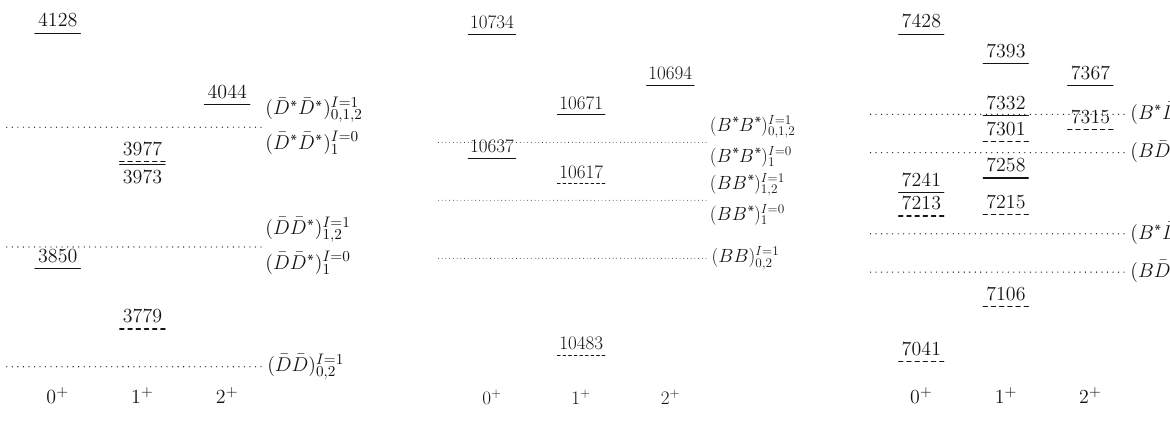
servation is satisfied and the total spin of a tetraquark is equal to a subscript of the symbol for a meson–meson channel, the corresponding S - or D -wave decay is